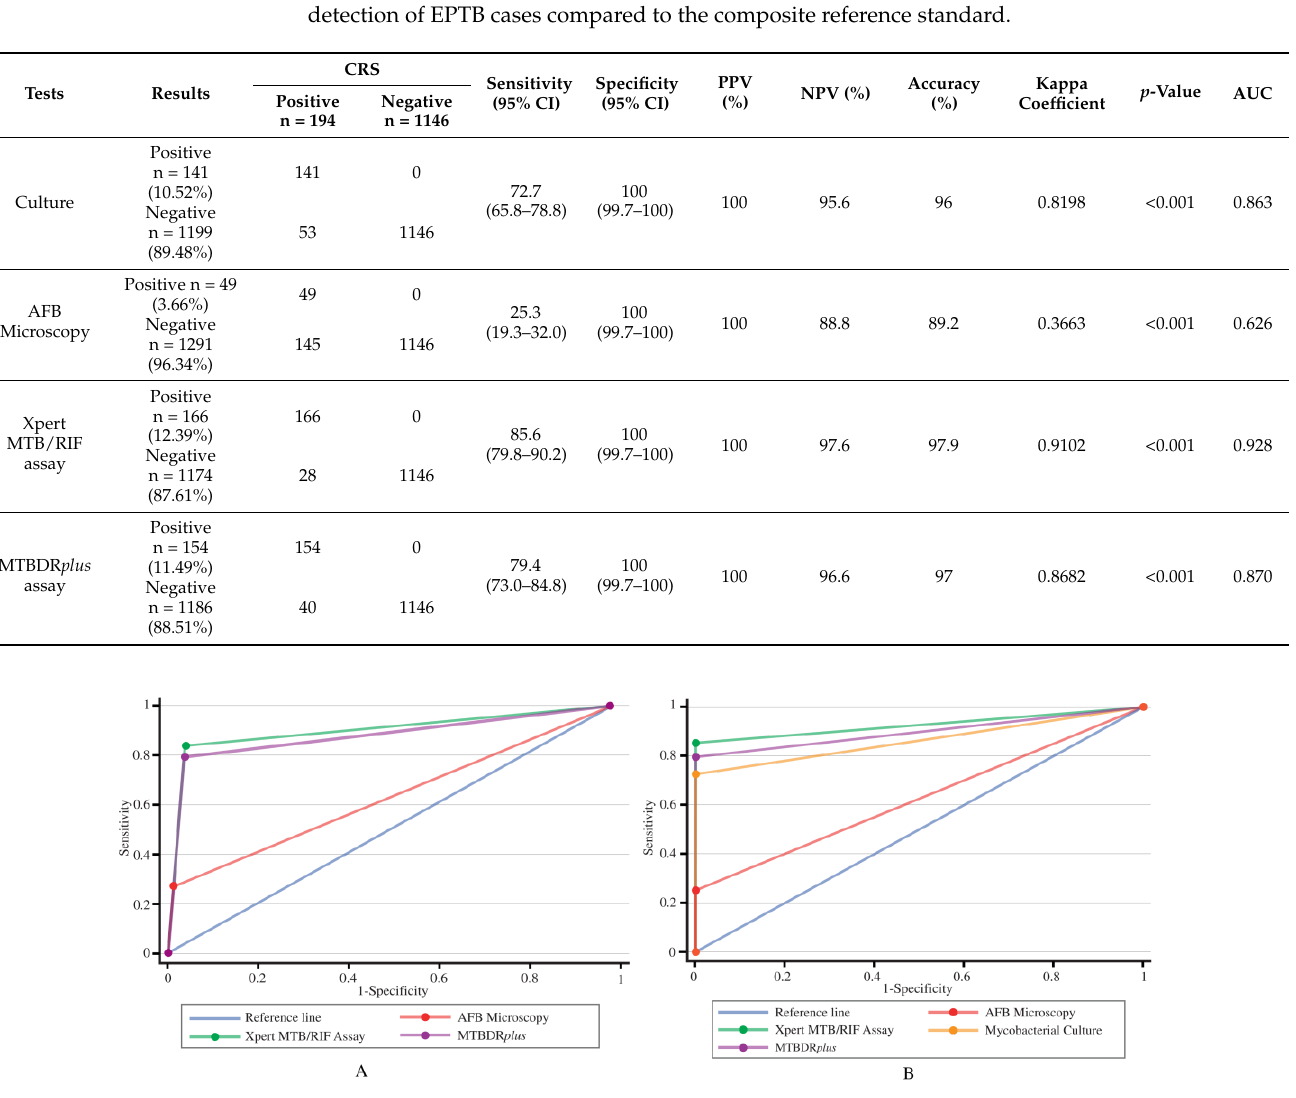
Table 2. Diagnostic performances of culture, AFB microscopy, Xpert MTB/RIF, and MTBDRplus for detection of EPTB cases compared to the composite reference standard.